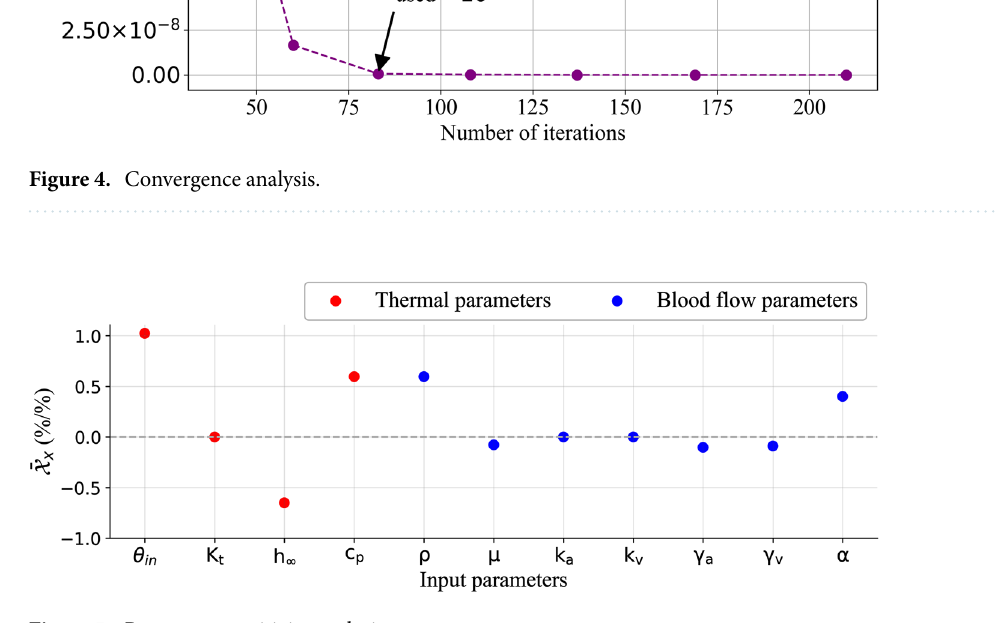
Figure 5. Parameter sensitivity